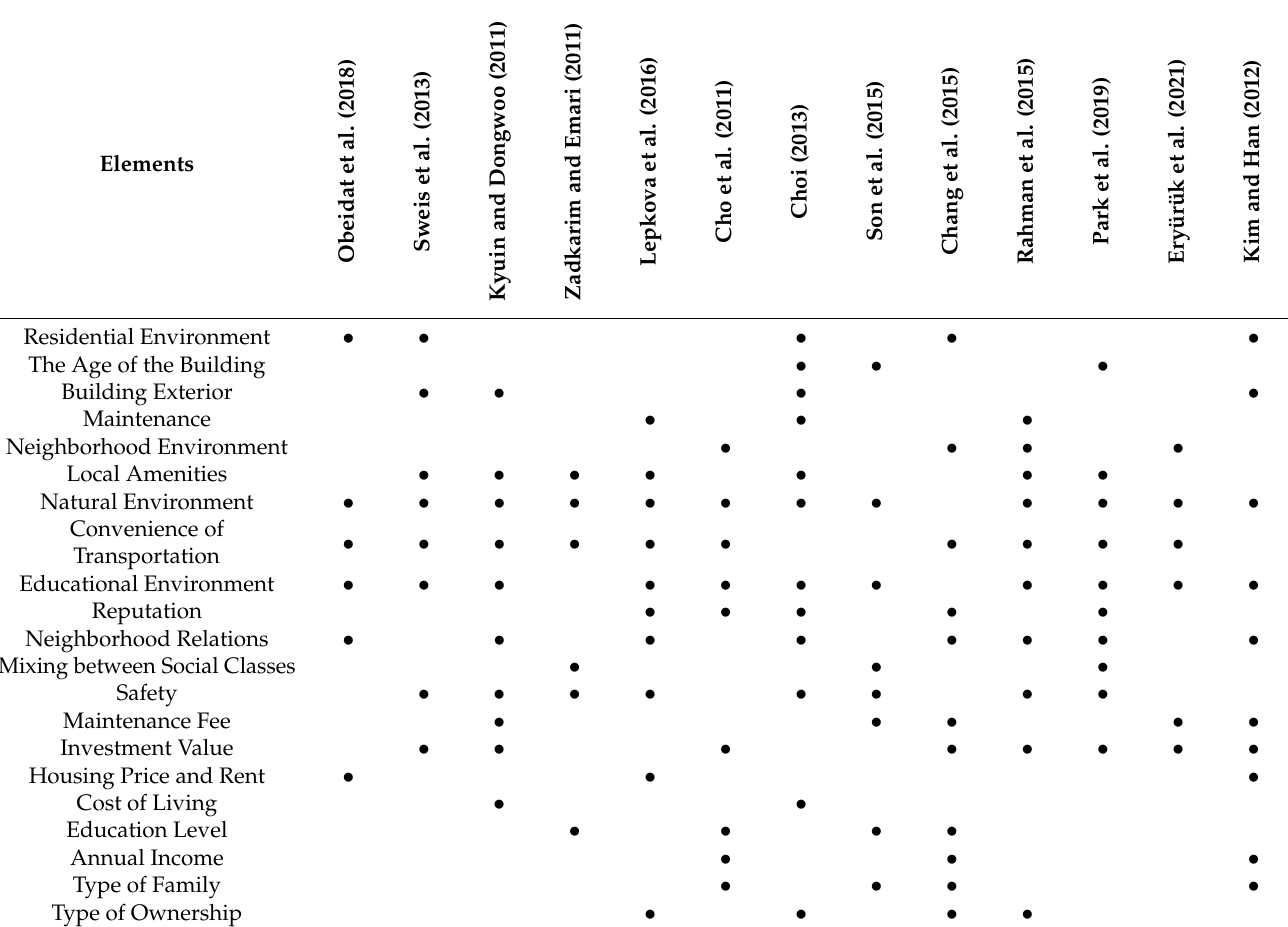
Table 2. The Review of Previous Research to Derive Housing